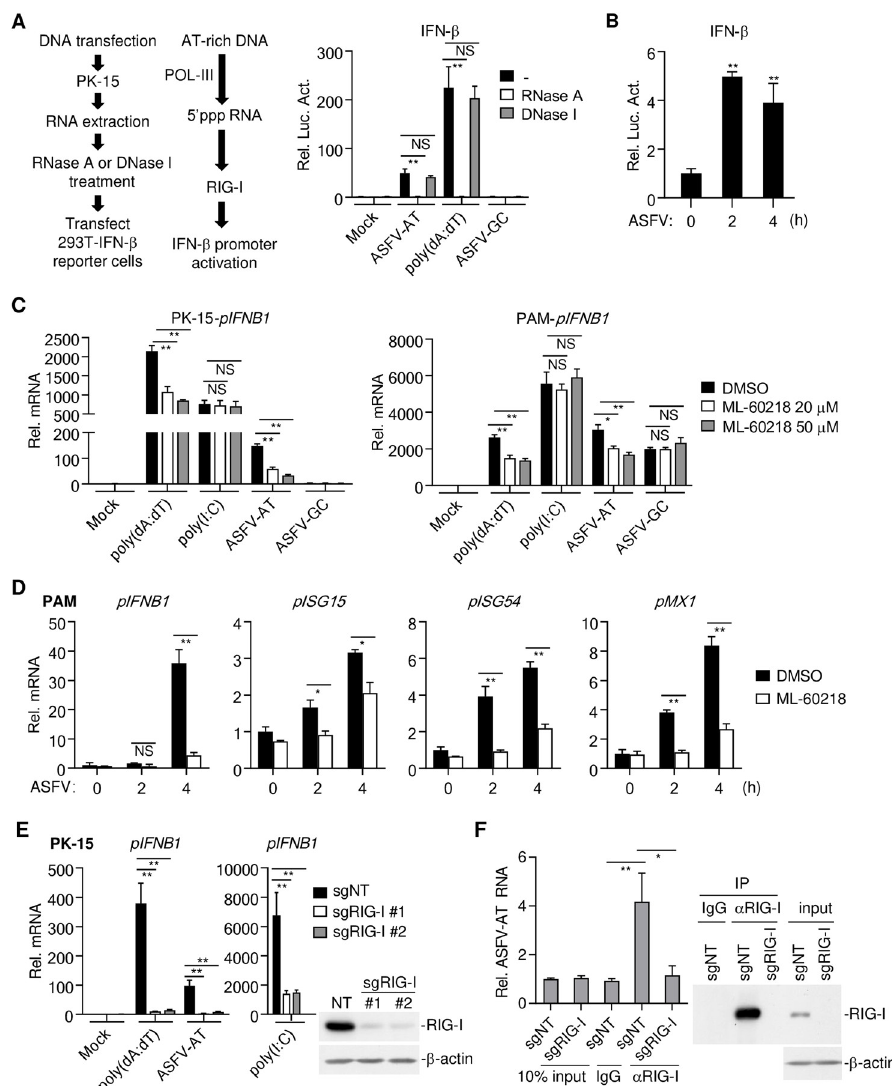
Fig 2. AT-rich regions of the ASFV genome activate RNA Pol-III-RIG-I axis. ( A ) RNAs extracted from poly(dA: dT)-, ASFV-AT-, ASFV-GC (1 μ g/ml) or mock-transfected PK-15 cells (2 × 10 6 ) were treated with RNase A or DNase I at 37˚C for 1 hour. The RNAs were then transfected into HEK293T (2 μ g/ml) that transfected with IFN- β -luciferase reporter. Six-hours later, luciferase assays were performed. The flow diagram of experiment was shown on the left. ASFV-AT indicates ASFV-AT-#1 hereafter. ( B ) PAMs (2 × 10 6 ) were mock infected or infected with ASFV (MOI = 0.1) for the indicated times. RNAs were extracted and treated with DNase (200 U/ml/mg RNA) at 37˚C for 1 hour. The RNAs were then transfected into HEK293T (2 μ g/ml) that transfected with IFN- β -luciferase reporter. Six-hours later, luciferase assays were performed. ( C ) PK-15 cells or PAMs (1 × 10 6 ) were pre-treated with the indicated concentrations of the RNA Pol-III inhibitor ML-60218 for 6 hours before transfection with poly(dA:dT), ASFV-AT, ASFV-GC or poly (I:C) (1 μ g/ml) for 4 hours. The mRNA levels of IFNB1 were analyzed by RT-qPCR. ( D ) PAMs (2 × 10 6 ) were pre- treated with ML-60218 (50 μ M) for 6 hours before infection with ASFV (MOI = 0.1) for the indicated times. The mRNA levels of IFNB1 , ISG15 , ISG54 , and MX1 were analyzed by RT-qPCR. ( E ) The effects of RIG-I-deficiency on poly(dA:dT)-, ASFV-AT- or poly(I:C)-stimulated IFN- β induction. Two sgRNA were used to knockdown RIG-I in PK-15 cells using CRISPR/Cas9 method (sgNT, non-targeting sgRNA). The mRNA levels of IFNB1 were analyzed by RT-qPCR after the cells were stimulated with transfected DNA or RNA analogs poly(I:C) for 6 hours. The knockdown efficiency of RIG-I was confirmed by western blot. ( F ) PK-15 cells (2 × 10 7 ) prepared as in (E) were transfected with ASFV-AT-#2 for 3 hours. RIP experiments were performed using the RIG-I antibody, and specific primers were used to detect the enrichment of ASFV-AT by RIG-I in cells. The expression of RIG-I in lysates and immunoprecipitations was detected by western blot